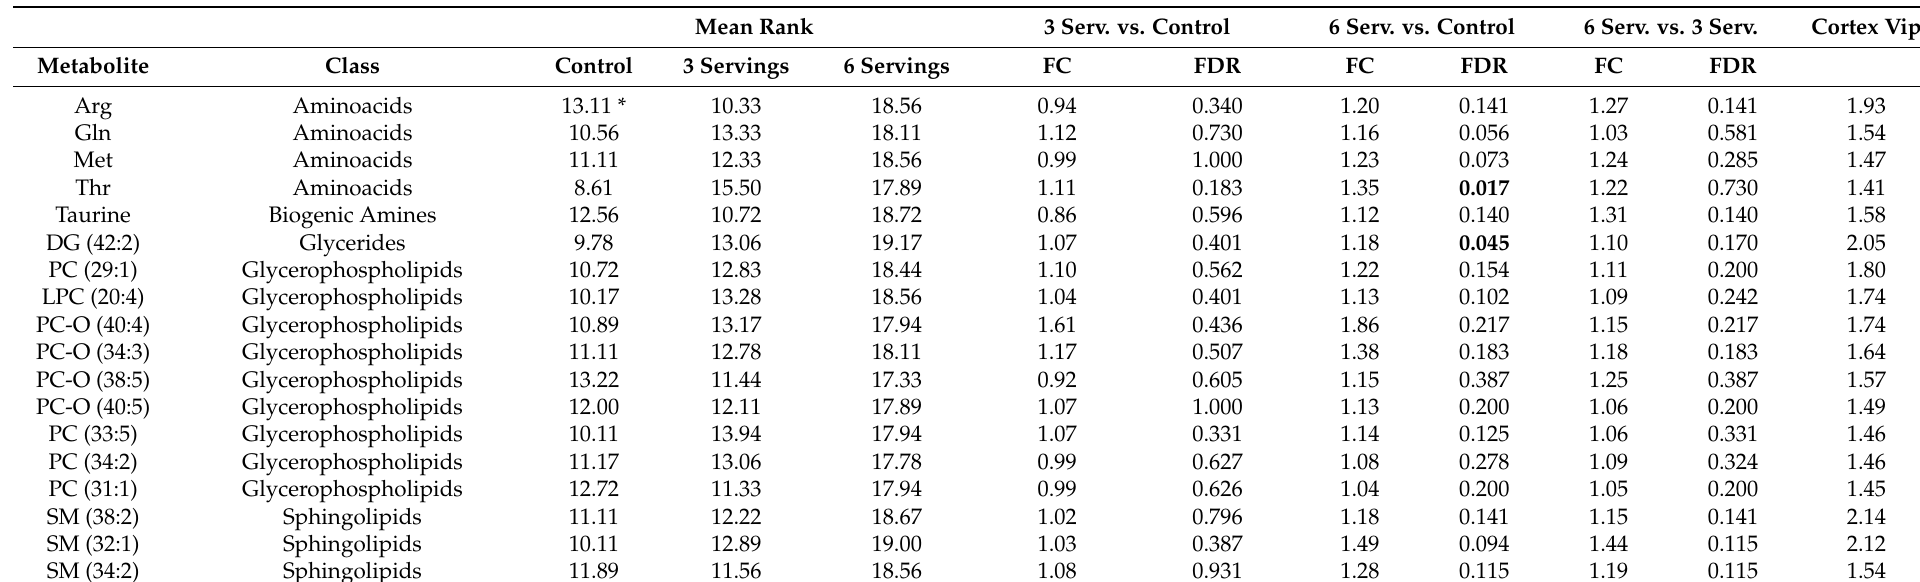
Table 2. Brain Cortex metabolites differences among treatment groups.